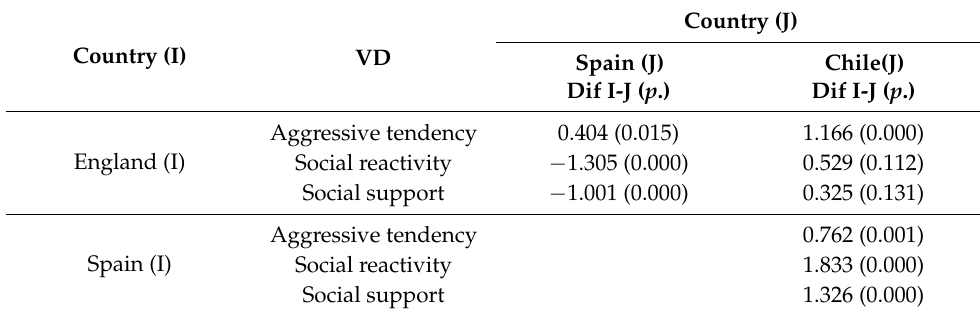
Table 5. Post hoc test of differences according to the variable country.